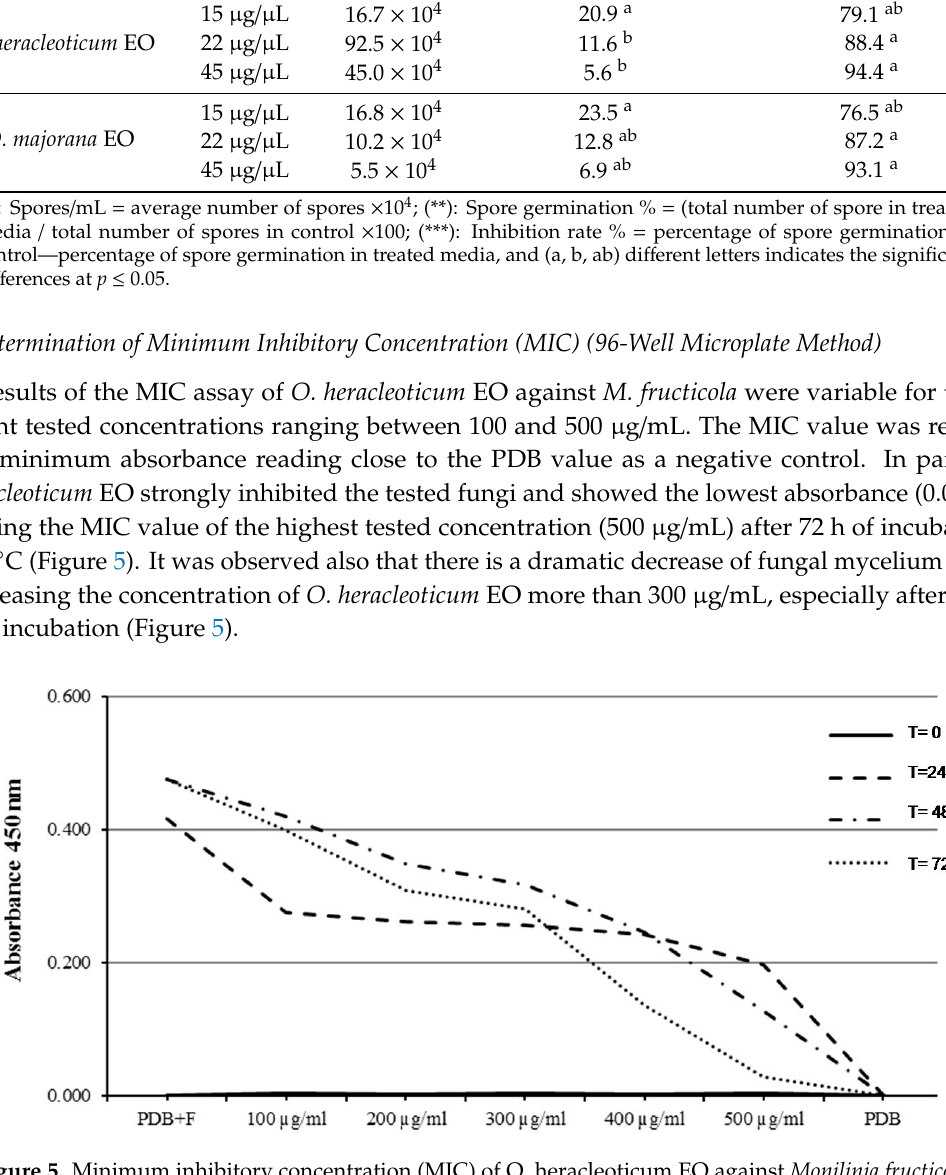
Figure 5. Minimum inhibitory concentration (MIC) of O. heracleoticum EO against Monilinia fructicola .